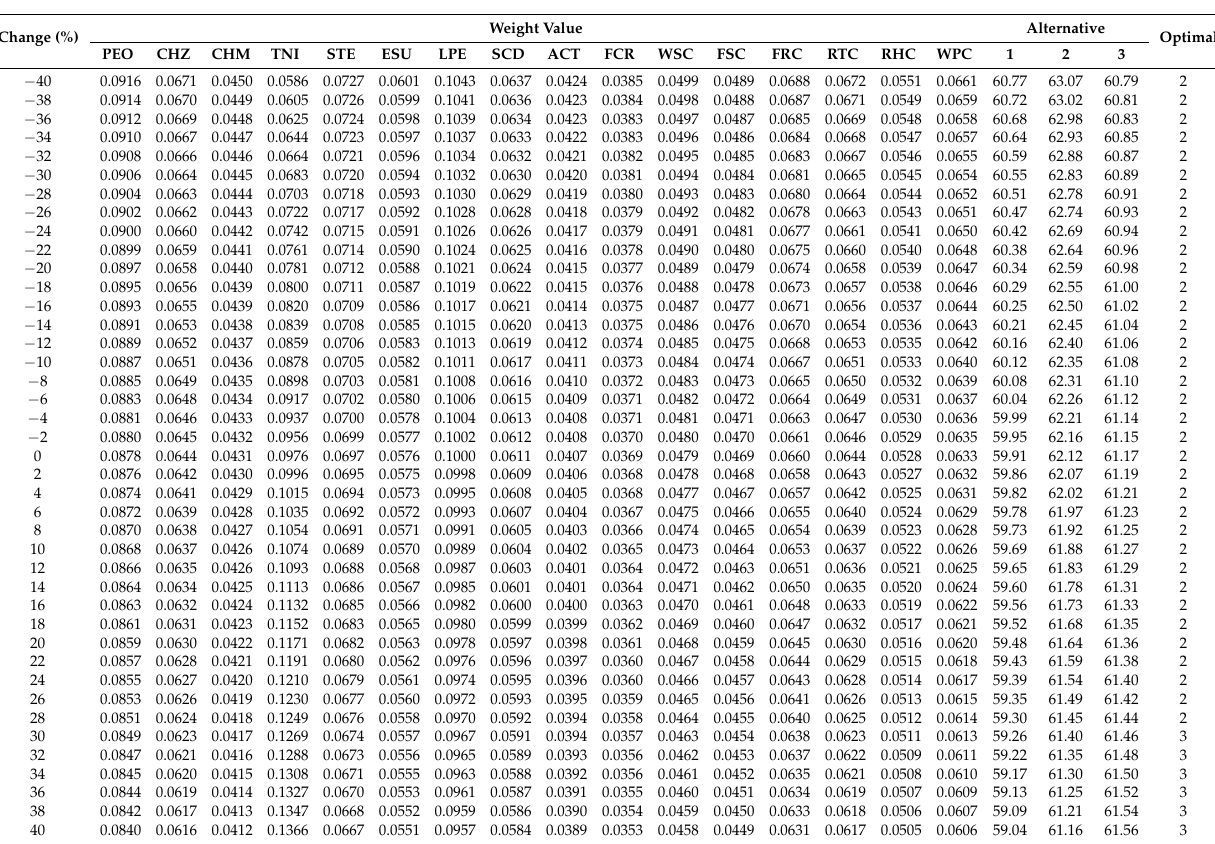
Table 9. Result summary from the simulation runs for the TNI criterion and selection of the optimal